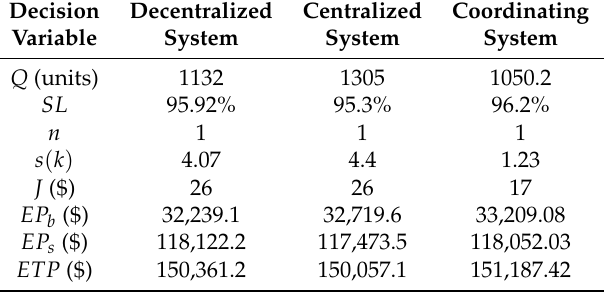
Table 3. Output data for numerical problem 2, in case of unreliable